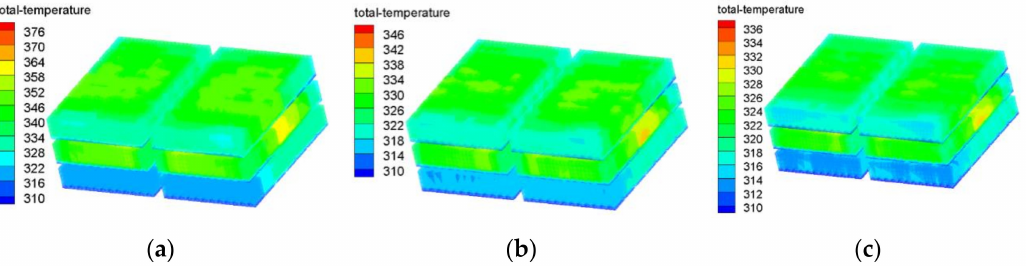
Figure 10. Temperature cloud diagrams for type IV battery pack under different inlet wind speeds: ( a ) 1 m/s; ( b ) 2 m/s; and ( c ) 2